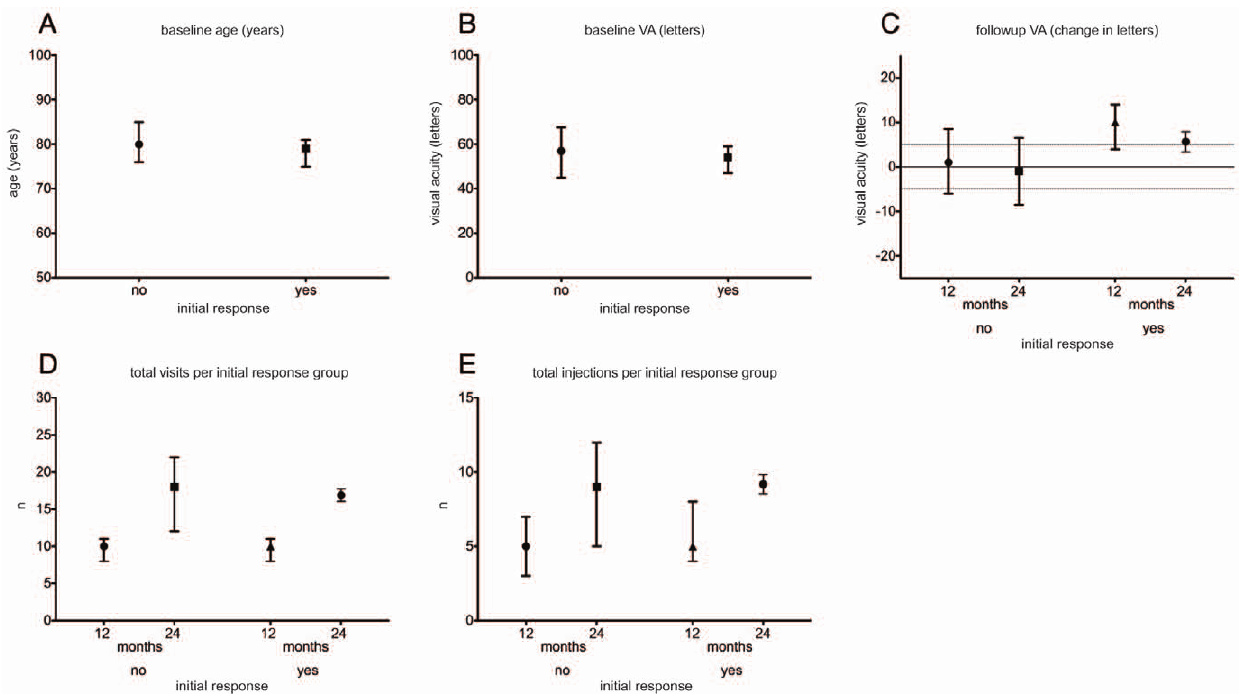
Figure 3. Overview of the initial response groups. Values are displayed for age at baseline (A), visual acuity at baseline (B), VA at 12 and 24 months (C), number of visits in 12 and 24 months (D), total injections in 12 and 24 months (E) and distribution of CFH genotypes (F) in the initial response groups. Symbols show the median while whiskers indicate the interquartile range. No statistically significant differences are found.